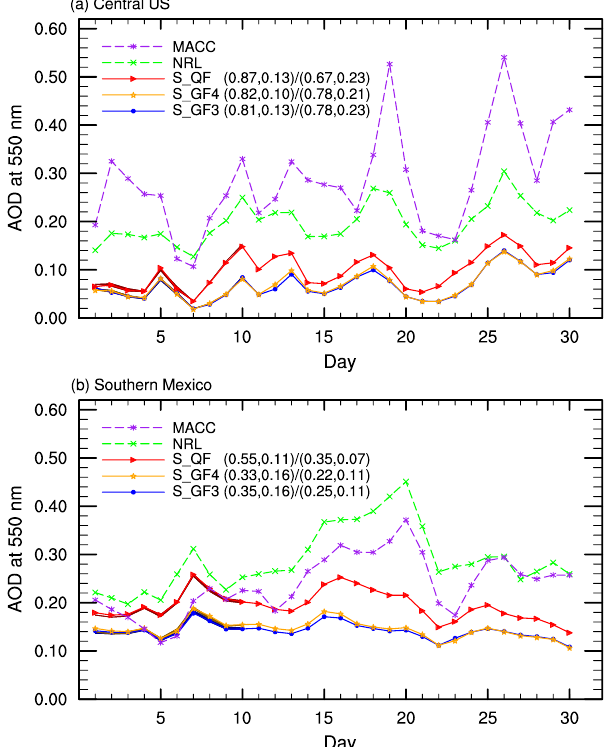
Figure 3. Time series of daily regional mean AOD in April 2009 in simulations and reanalysis data. Numbers in parentheses de- note time correlation coefficient (TCC) and root mean square error (RMSE) between each simulation in group A and reanalysis data (left: NRL; right: MACC). Individual lines indicate group A sim- ulations. Shaded areas (very narrow) in slightly darker colors dur- ing 1–10 April illustrate maximum and minimum values of daily mean AOD among ensemble members in group B simulations. For the single-member simulation and the ensemble simulation driven by same fire emission, the shaded area and the solid line almost overlap, given the barely indistinguishable AOD between ensemble members and the corresponding group A